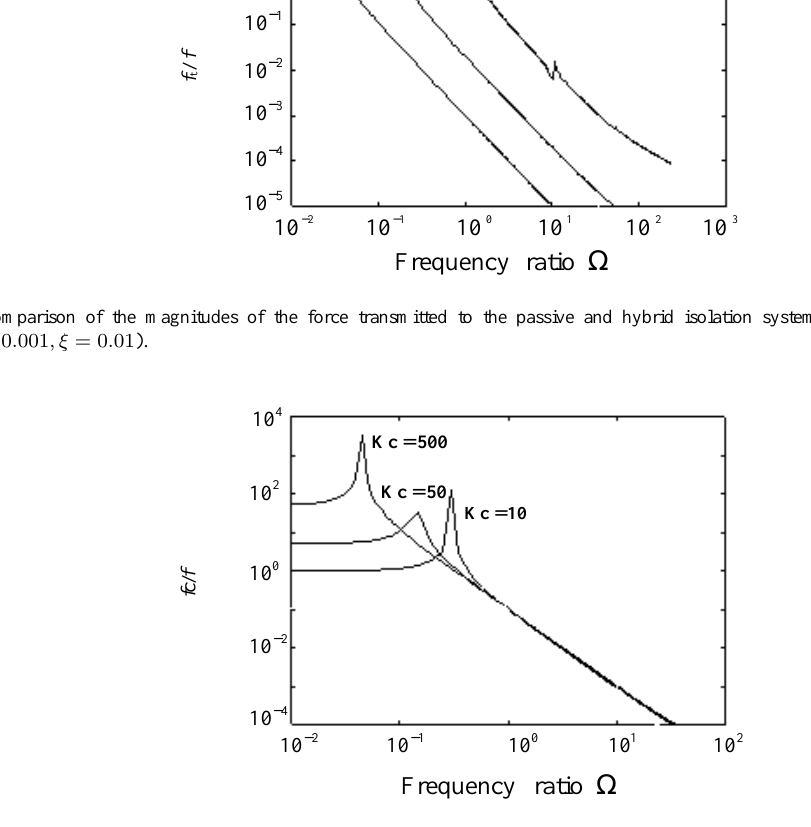
Fig. 3. Control force required for the parallel hybrid mount in the isolation system ( µ = 0 . 5 ,ω 1 /ω 0 = 10 ,γ = 2 ,δ = 0 . 001 ,ξ = 0 . 01 ).